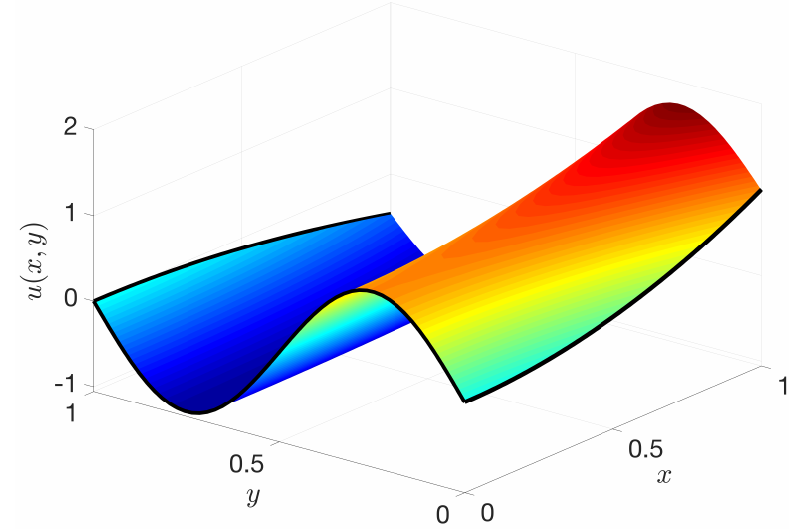
Figure 2. Multivariate example # 1 constrained expression evaluated using g ( x , y ) = x 2 cos ( y ) +